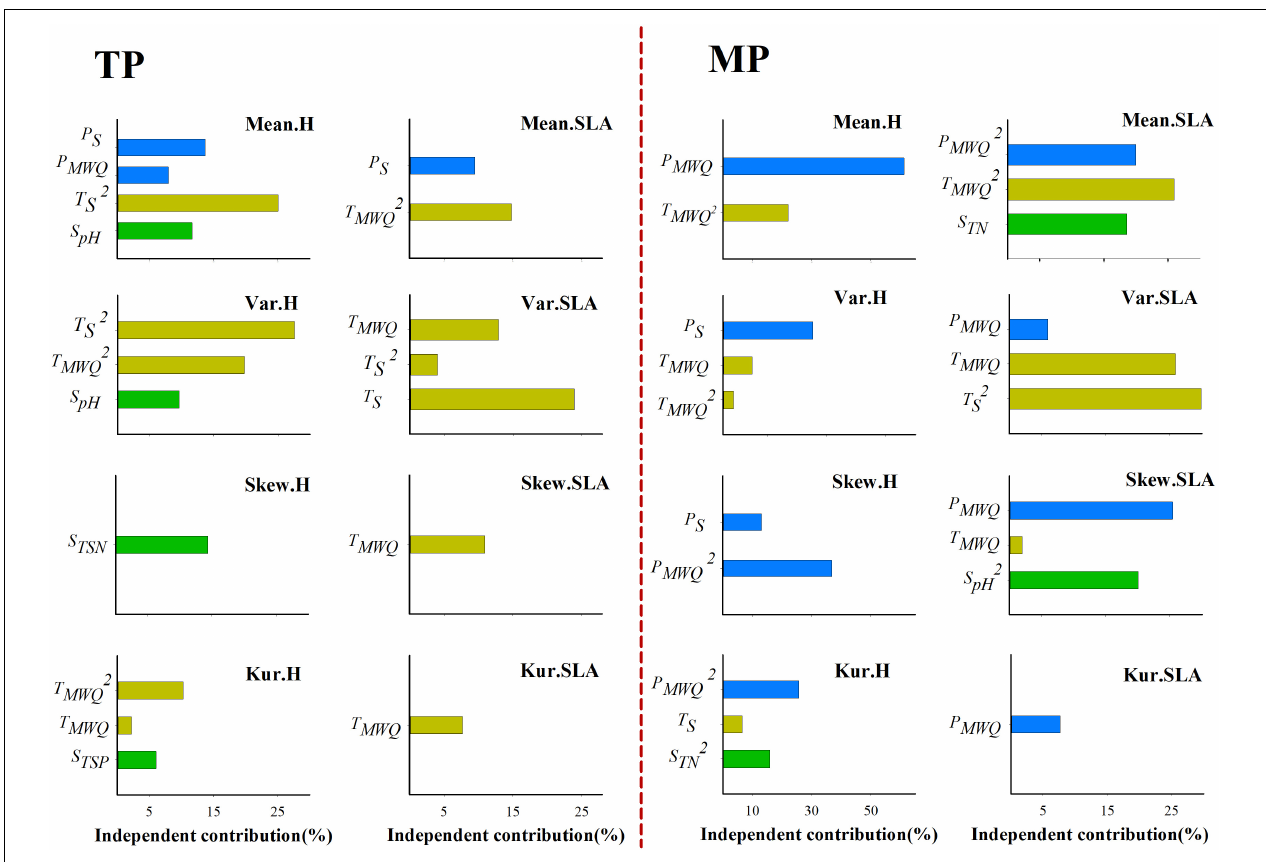
FIGURE 3 | Independent influence of abiotic variables on the variations in mean, variance, skewness, and kurtosis of the height and SLA distributions within grassland communities. Skew.H and Skew.SLA represent community-weighted skewness of height and SLA, respectively; Kur.H, and Kur.SLA represent community-weighted kurtosis of height and SLA,